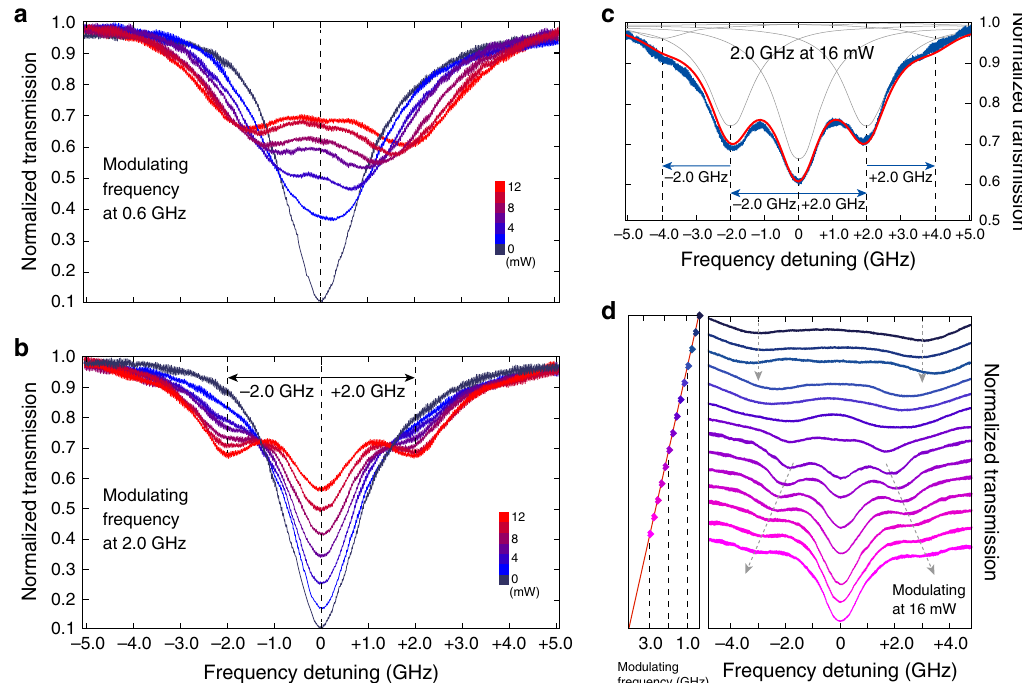
cavity mode with RF driving signal at 01